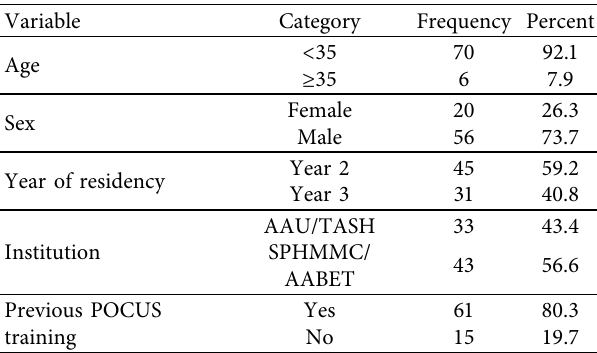
Table 1: Sociodemographic characteristics of senior emergency medicine and critical care residents in SPHMMC and